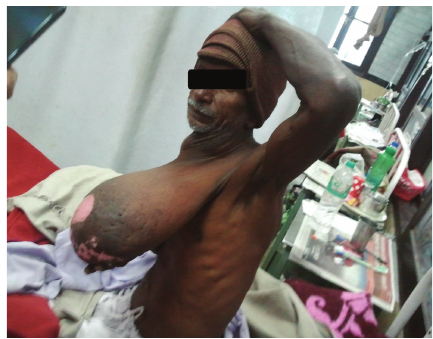
Figure 1: Preoperative view of lipoma.